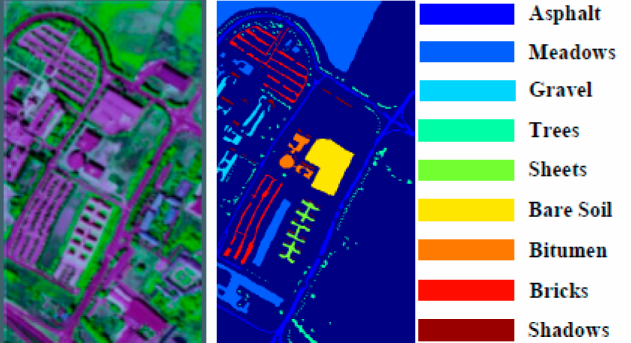
Figure 4. The false color images and ground truth map of the PaviaU dataset. The original image size is 610 × 340 pixels.